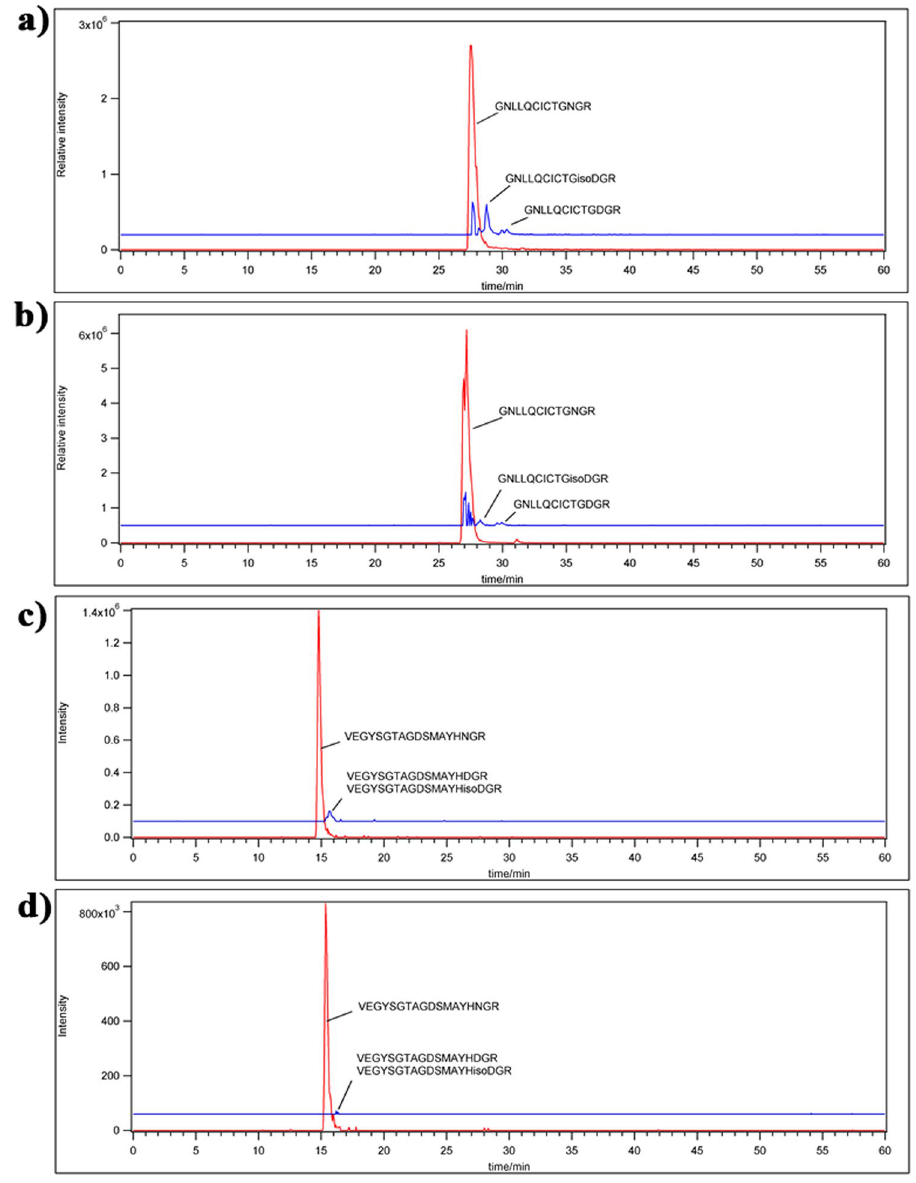
Figure 2. LC-MS/MS analysis of FN and TNC as extracted from cell culture plates treated with TEAB or PBS- only control. Shown are the FN peptide GNLLQCICTG N GRGEW native ( a ) and deamidated ( b ) forms as well as TNC peptide VEGYSGTAGDSMAYHNGR native ( c ) and deamidated ( d ) forms as identified by Mascot search of the MS/MS spectra. The percentage of deamidation of each targeted NGR motif was determined by integrating the area of the extracted ion chromatogram with + / − 5 ppm mass range of the calculated precursor masses of the native and deamidated peptides. TEAB-induced deamidation was 8% for FN and 5.3% for TNC, whereas only trace levels of protein deamidation were detected in the PBS-only control